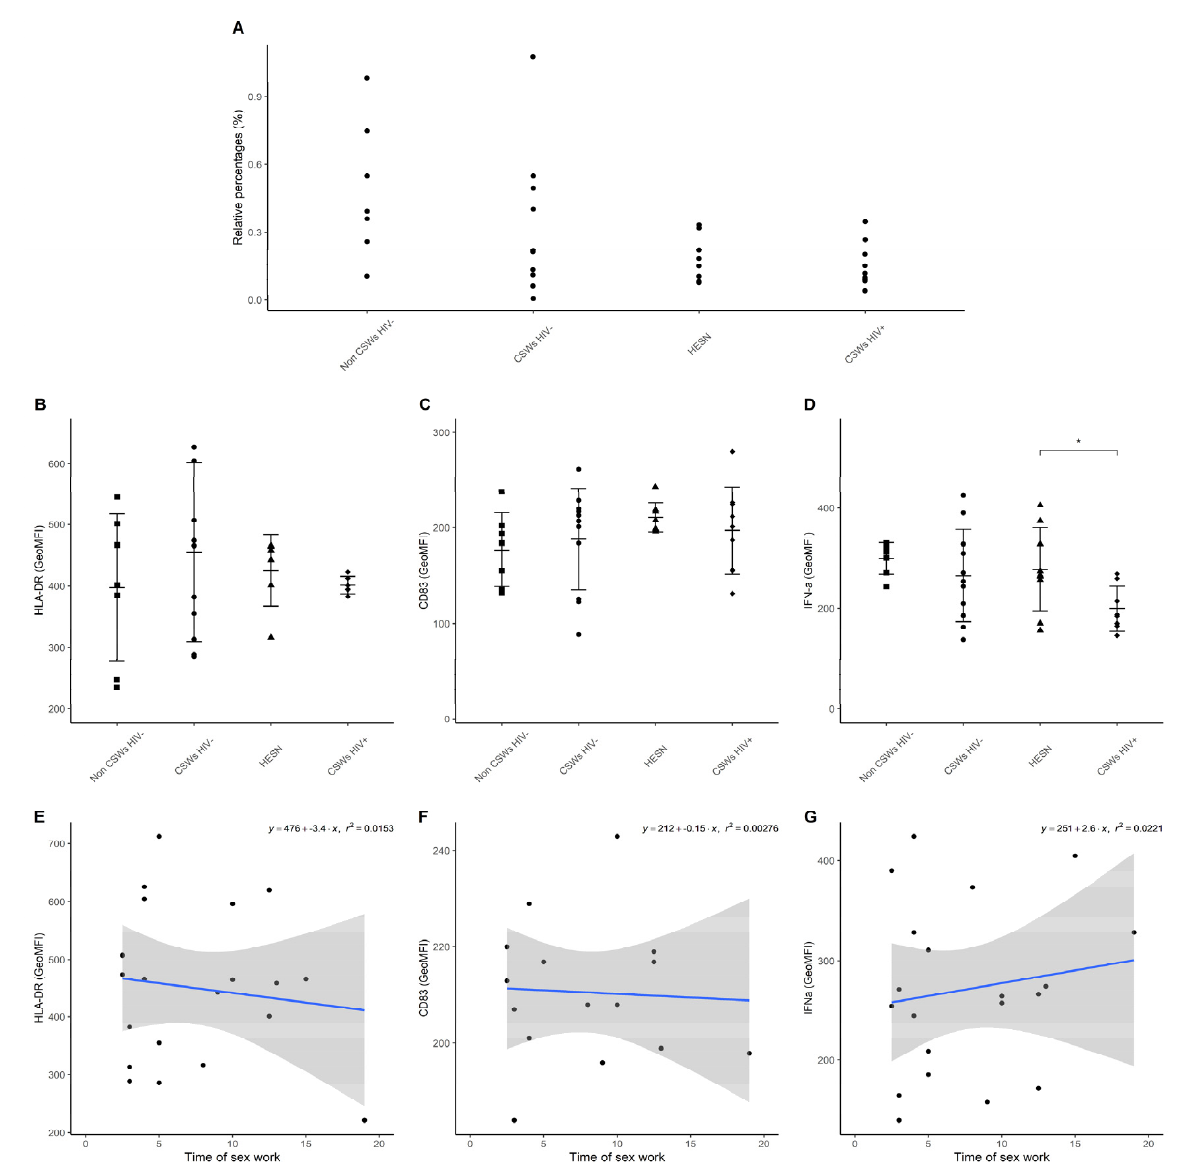
Figure 7. Flow cytometry analyses of pDCs. ( A ) pDC relative frequencies were calculated vs. total live PBMCs, ( B ) HLA-DR, ( C ) CD83, and ( D ) ex vivo intracellular IFN- α expression levels as determined by geometric mean fluorescence intensity (GeoMFI). Data are presented as the mean value ± SD of samples from 7 non-CSWs HIV- (HIV-1-uninfected control women from the general population), 9 CSWs HIV- (HIV-1-uninfected 2.5–5-year CSWs “early HESNs”), 11 HESNs (HIV-1-uninfected ≥ 10 years CSWs), and 9 CSWs HIV+ (HIV-1-infected CSWs). Significance levels are shown as * ( p < 0.05). ( E – G ) Linear regression analyses are shown for CSWs HIV- (HIV-1-uninfected 2.5–5-year CSWs “early HESNs”) and HESNs (HIV-1-uninfected ≥ 10 years CSWs).